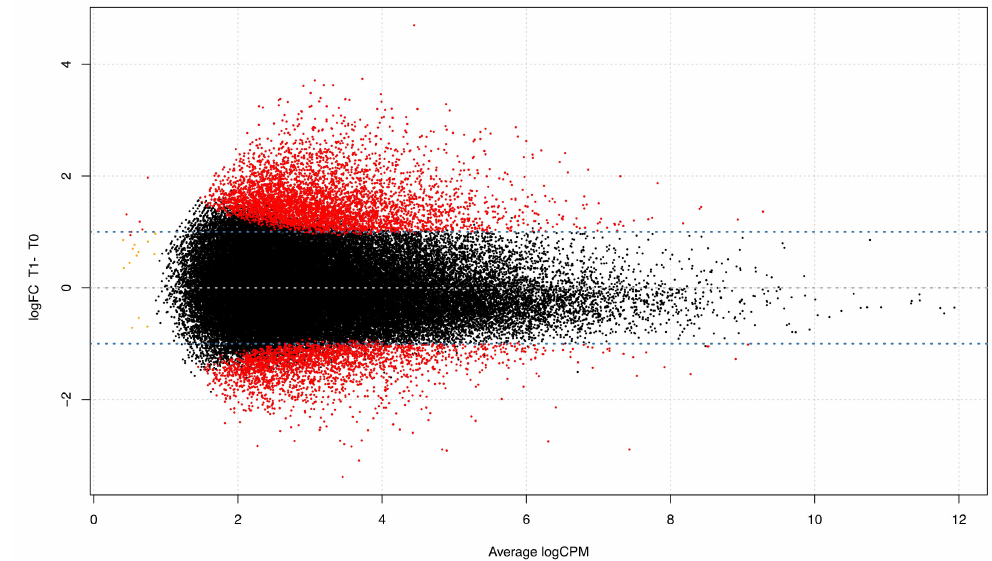
Figure 4. Smear plot of di ff erentially expressed repetitive elements genome wide, red dots indicate the entries that overcome the fold change threshold (Y axes) and are significantly (q < 0.5) di ff erent between T0 and T1. X axes represent the expression value within the